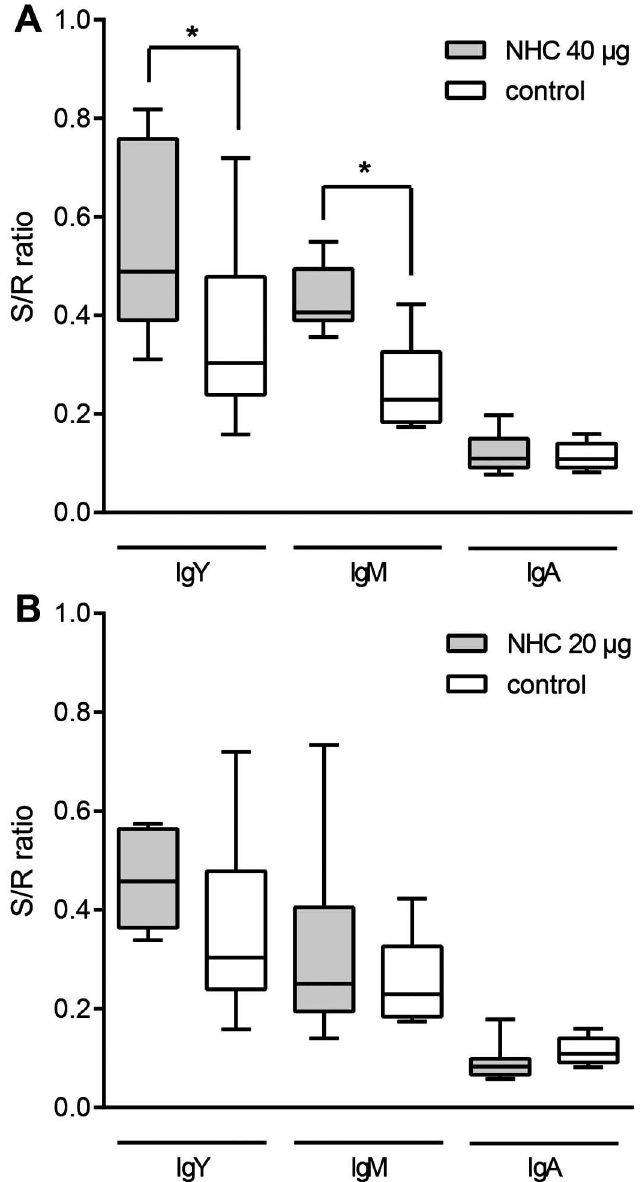
Fig 3. Antigen-specific serum antibody responses. NHC flagellin-specific antibody levels in the groups immunized with ( A ) 40 μ g of NHC protein and ( B ) 20 μ g of NHC protein, both compared to levels in the solvent injected control group. Antigen-specific IgY, IgM or IgA antibody levels were determinedin 20-fold diluted sera collected from 12 day-old individualanimals. Results are displayedas a box-and-whisker plot (S/ R, sample to reference ratio). An asterisk indicates statistically significant differences ( α < 0.05) between compared groups.